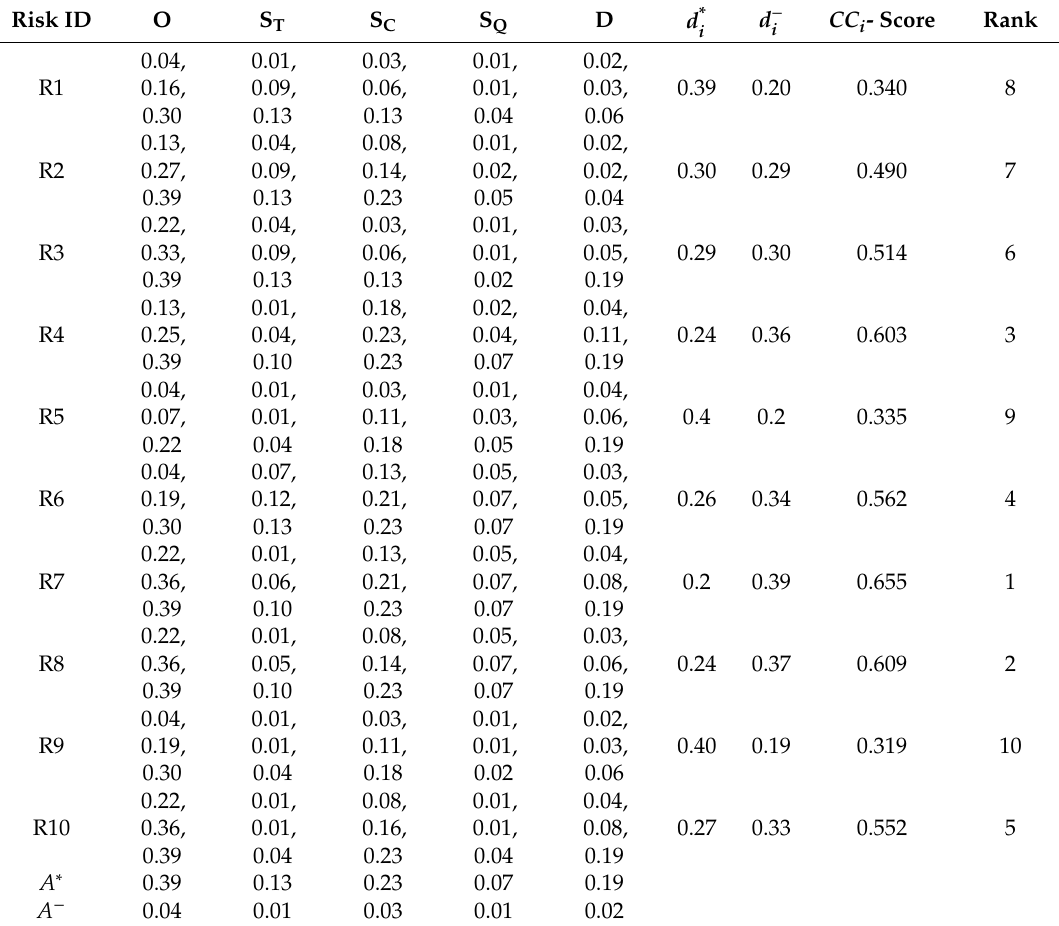
Table 9. The non-equilibrium matrix and calculating the closeness coe ffi